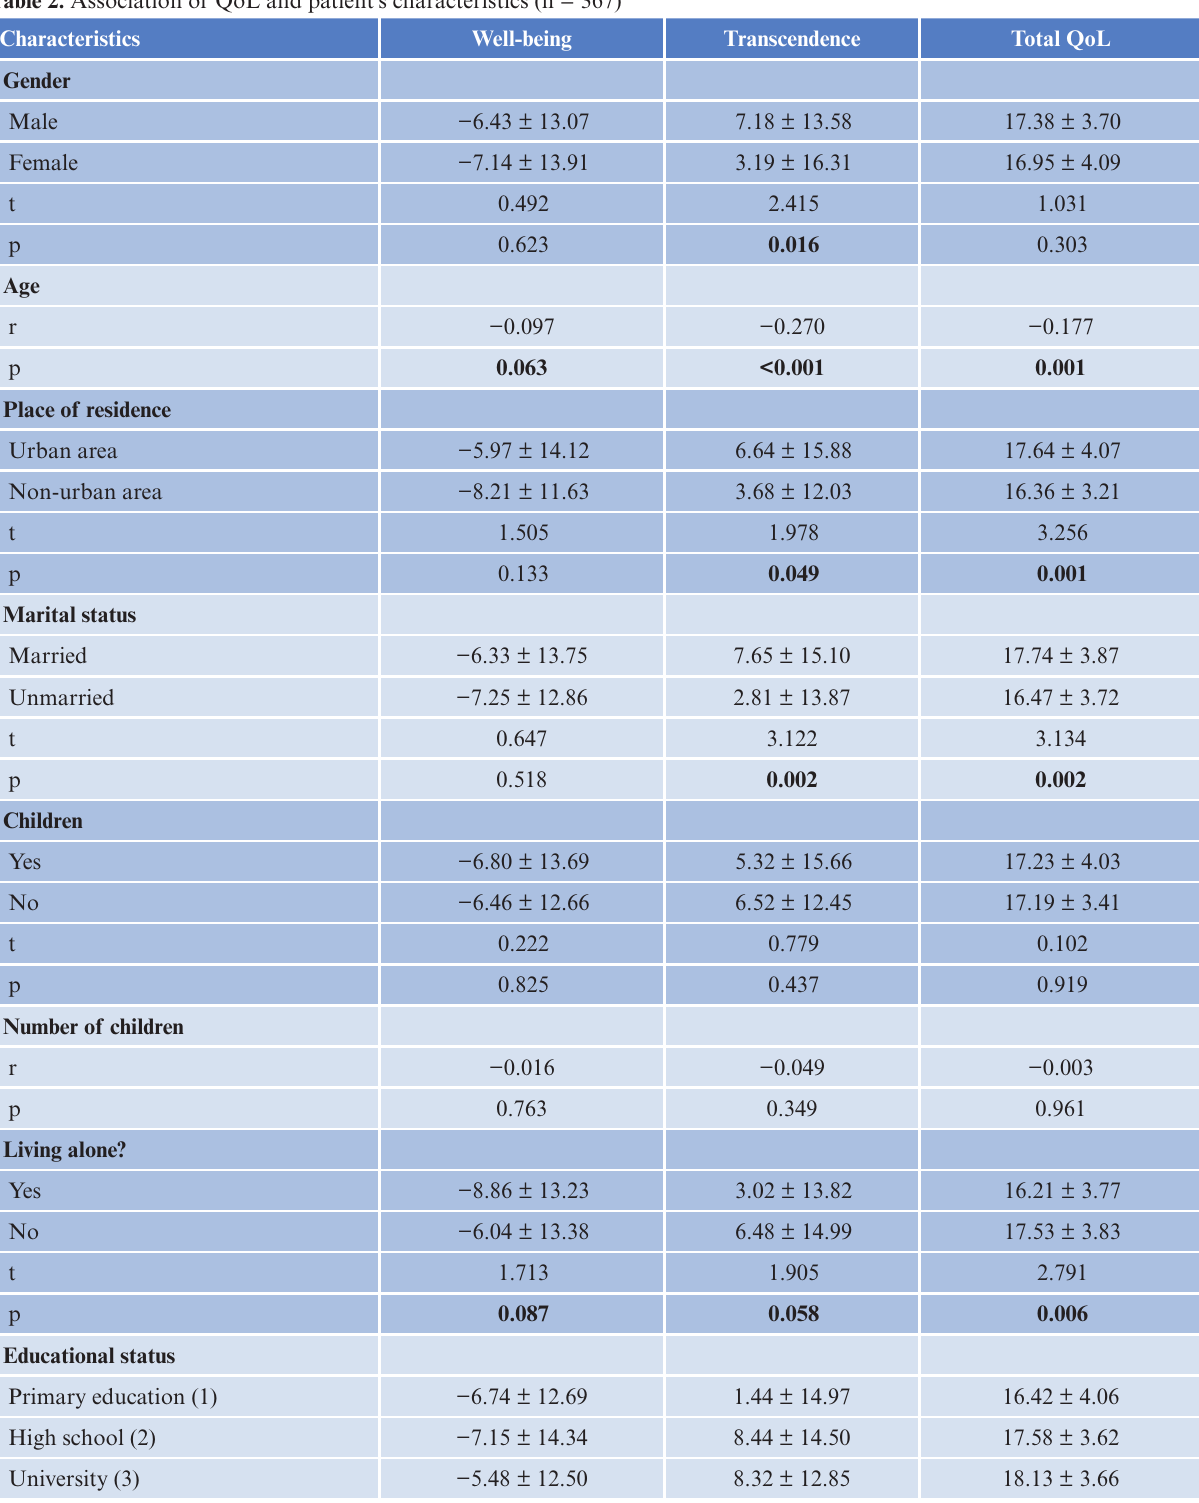
Table 2. Association of QoL and patient’s characteristics (n = 367)